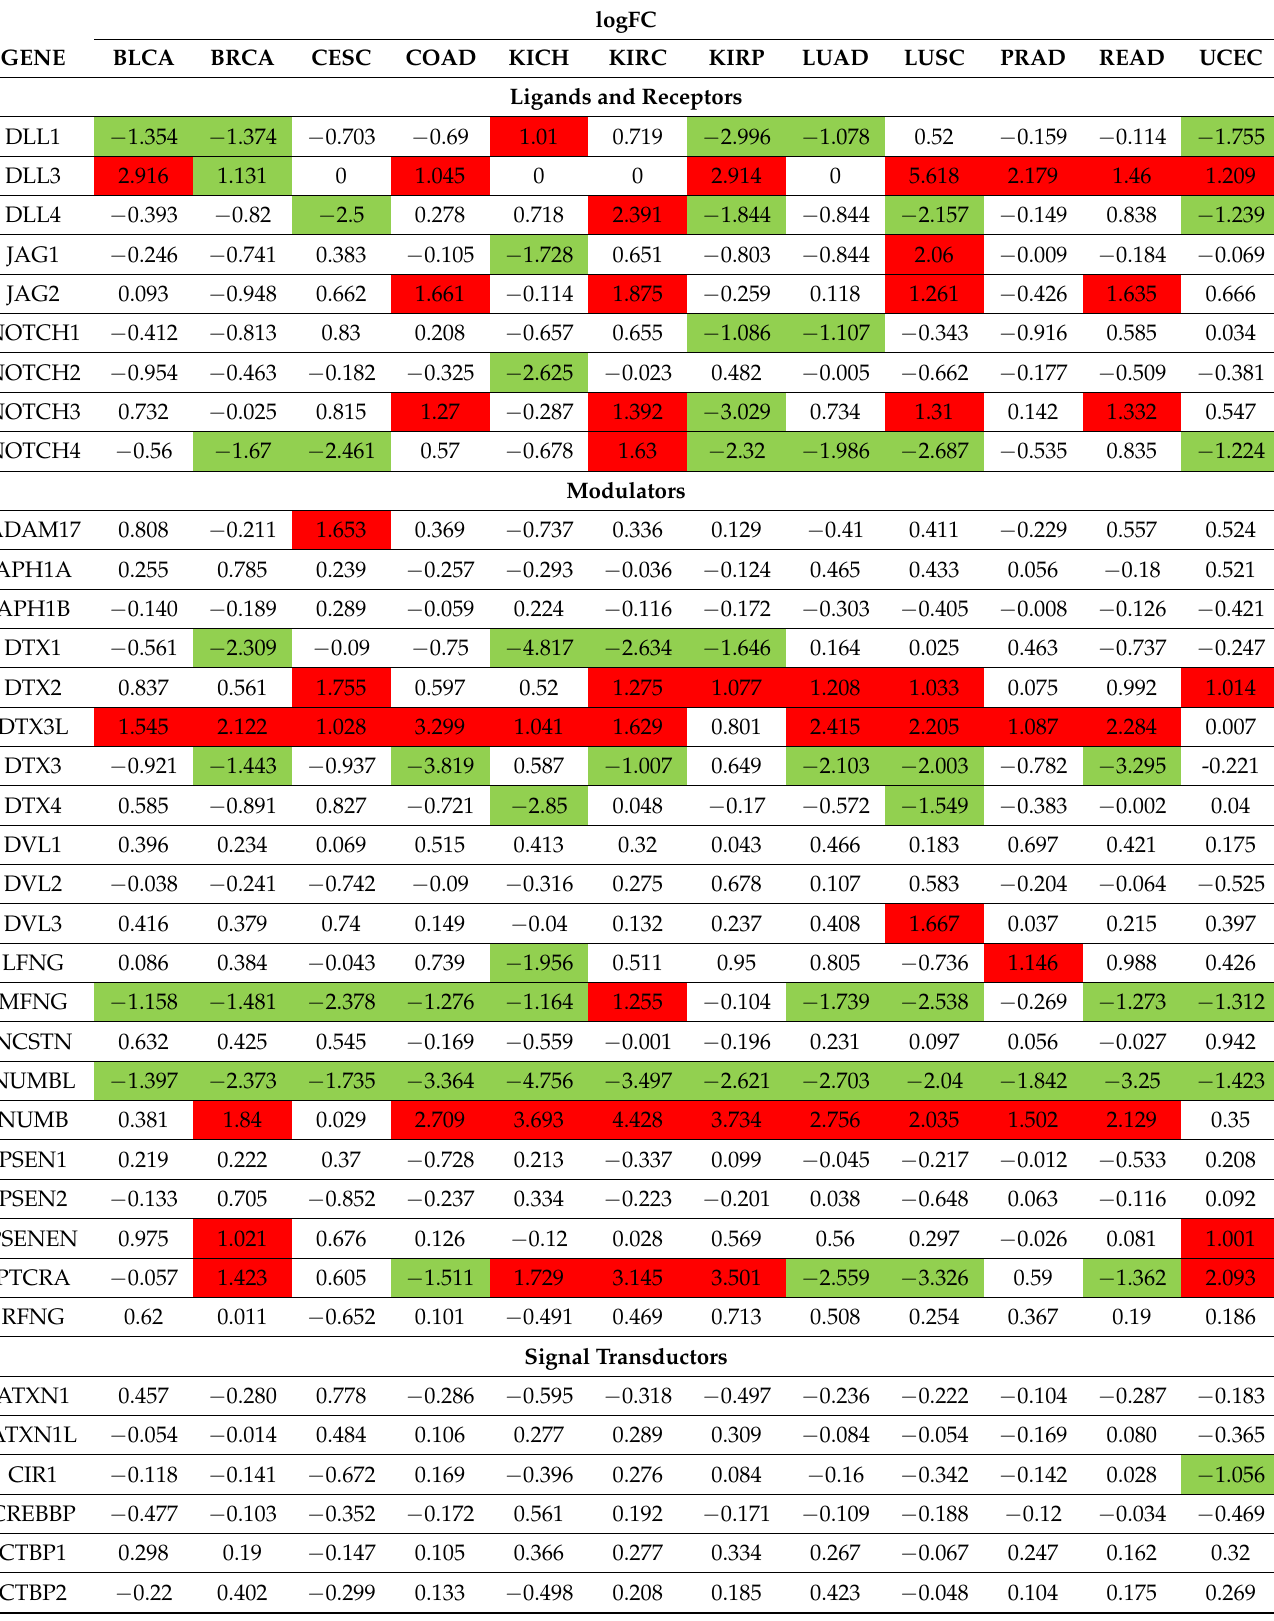
Table 1. LogFC values of core Notch components. logFC was calculated between cancer and normal samples. Green color indicates double or higher expression in normal samples; red color indicates double or higher expression in cancer